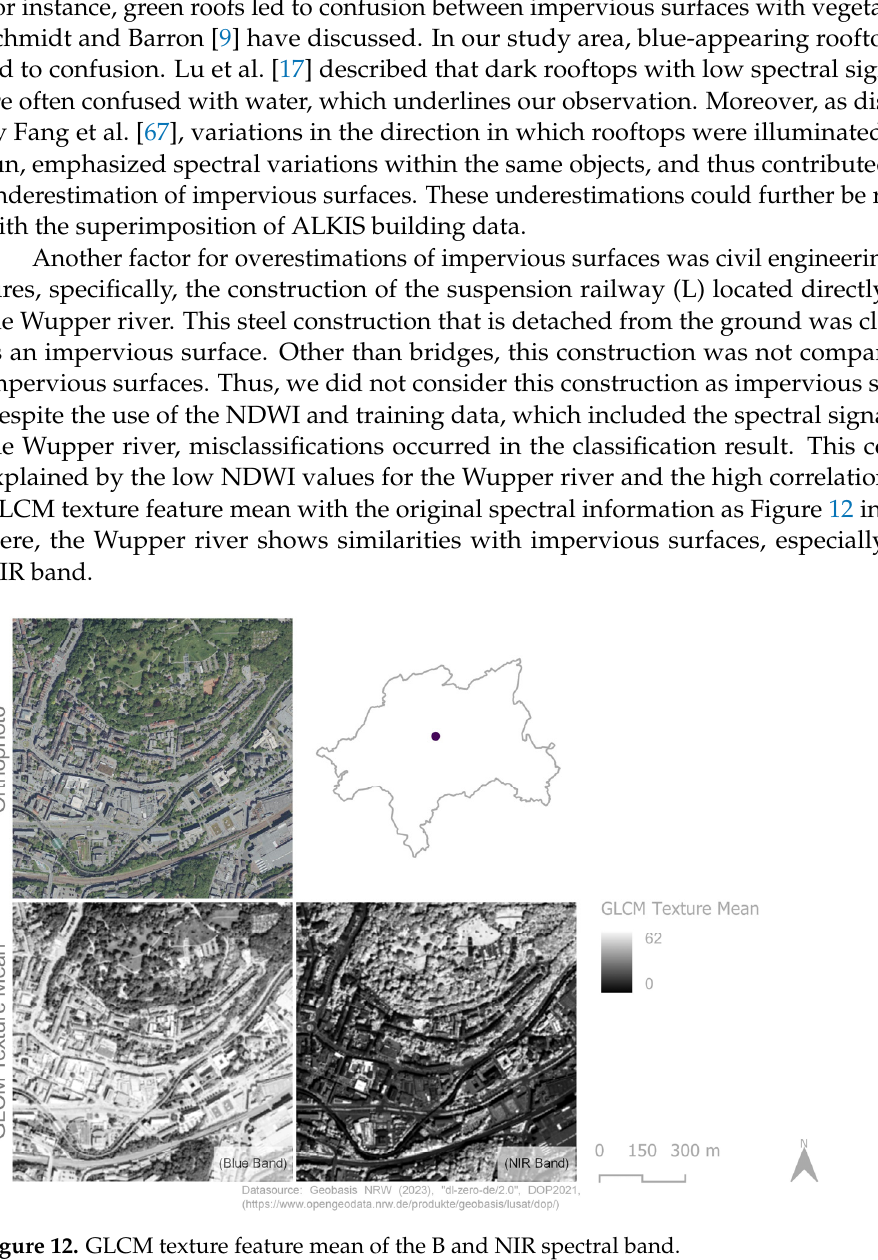
Figure 12. GLCM texture feature mean of the B and NIR spectral band.